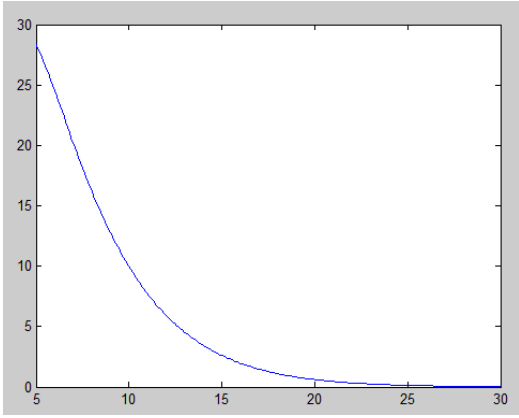
Figure 2. Partial graph of f ( e ) ( 5 30 e ).